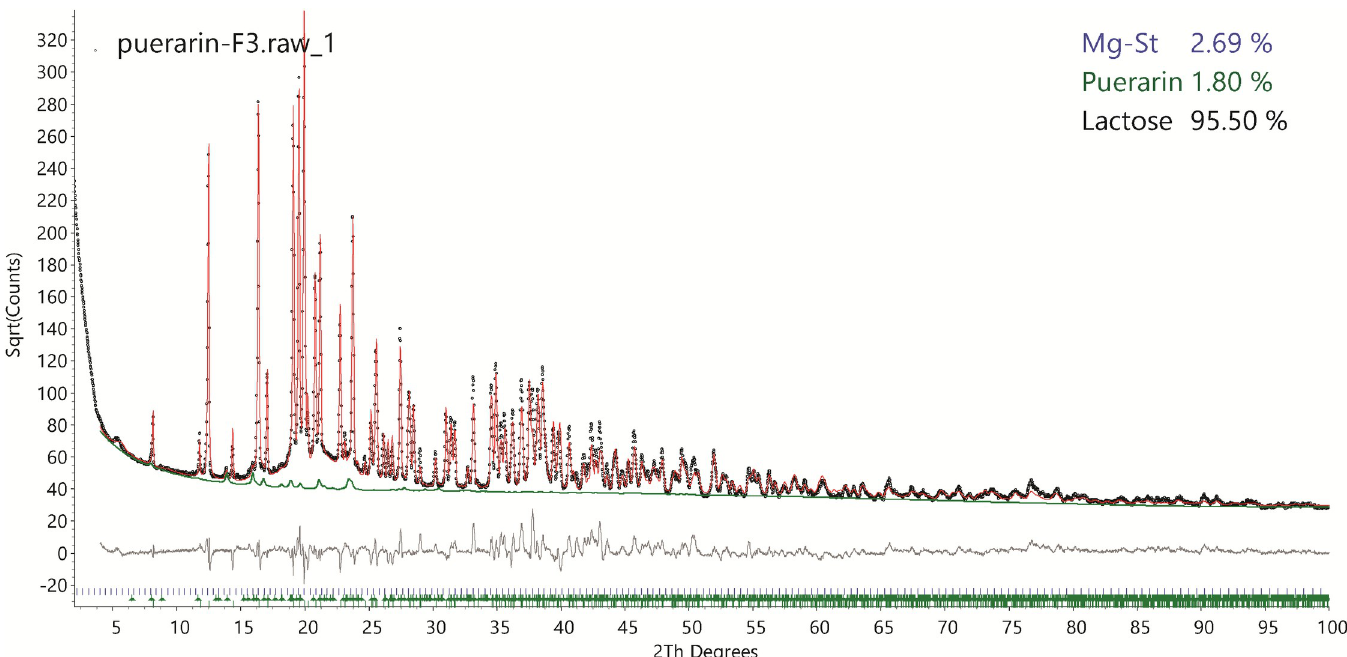
Fig 8. Quantitative phase analysis of the formulation F3. The weight percentage of each ingredient are shown in the upper right corner. The diffraction signal contribution from the API, puerarin, is highlighted in the green line.